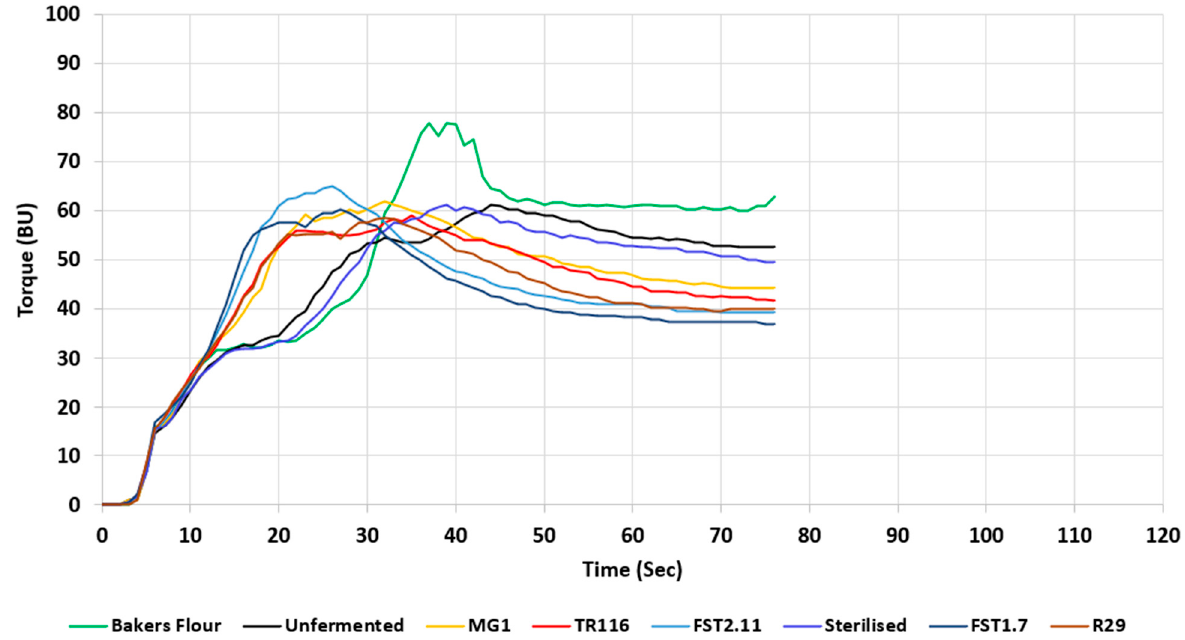
Figure 1. Effect of unfermented and fermented rootlets on the gluten network development of bakers’ flour as dough torque (BU) over mixing time (s). TR116, FST2.11, MG1, FST1.7, and R29 denote wheat flour blends with 5% inclusion of the fermented rootlets, fermented with Leuconostoc citreum TR116, Lactobacillus amylovorus FST2.11, Weissella cibaria MG1, Lactiplantibacillus plantarum FST1.7, and Limosilactobacillus reuteri R29, respectively. Bakers’ flour, 5% supplementation of unfermented rootlets, and 5% supplementation of sterile rootlet flour blends are also represented in the illustration.